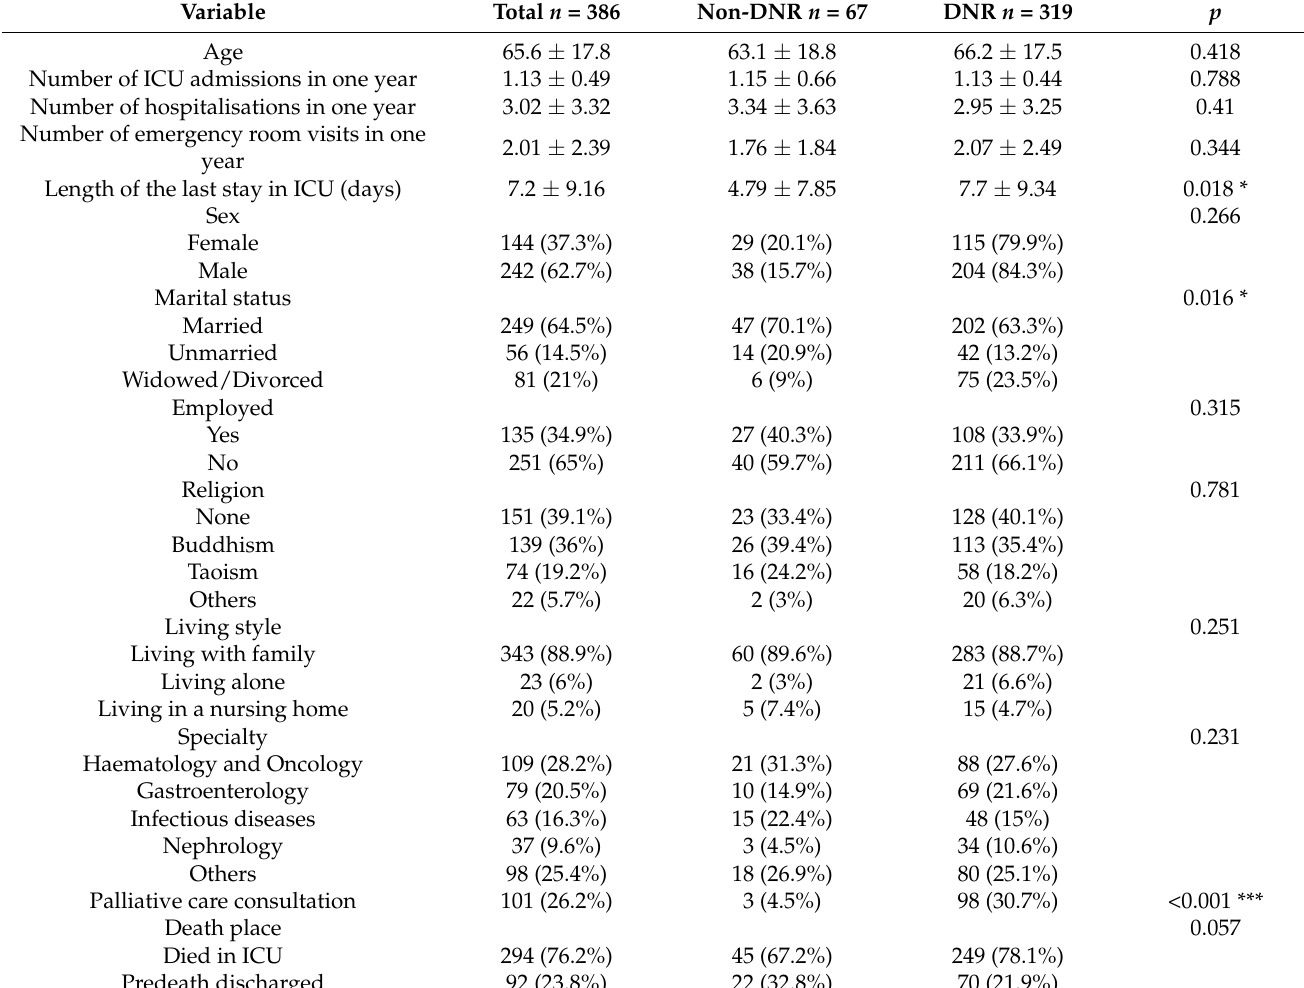
Table 1. Demographic parameters and comparison between the non-DNR and DNR